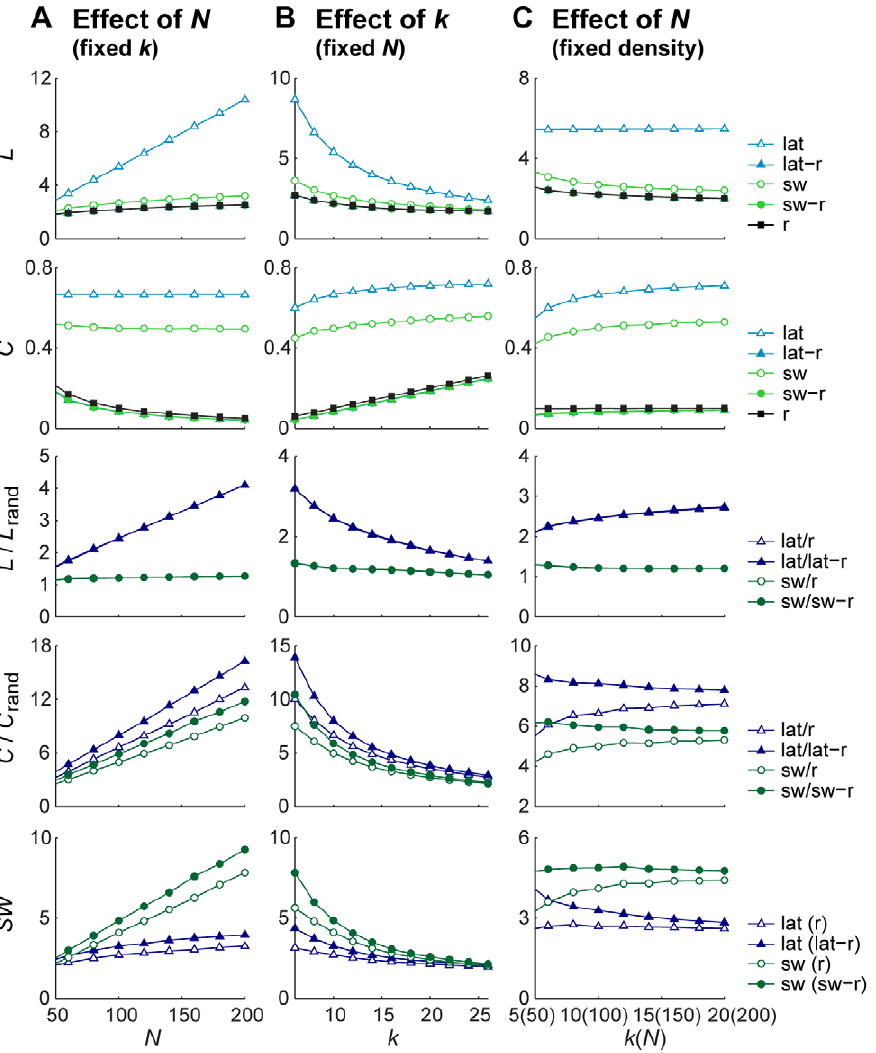
Figure 3. Normalized graph measures using random surrogates remain sensitive to network size and average degree. Path length ( L ) and clustering coefficient ( C ) normalized by dividing values from a lattice and small-world network (rewiring probability=0.1) by those of random networks still depend on the network’s number of nodes ( N ) and average degree ( k ) because their curves as function of N and k are specific for each type of network. Small-world networks (sw) fall in between lattices (lat) and random networks (r) and so the influence of normalization on the N,k - dependence is smaller compared to lattices. Since L for small-world networks is close to that of random networks, normalization improves the independence of N and k (more horizontal curves). By contrast, C is close to that of lattices and normalization introduces a bias that is larger compared to the non-normalized measure. Because of this, the small-world index ( SW ) is also greatly affected by N and k . There is little to no difference for Erdo¨s-Re´nyi networks and random networks with the same degree distribution as the original network (lat-r, sw-r) and even coincide for L . The legend for SW indicates between brackets the type of random surrogates used in the calculation. A : Effects of changes in the number of nodes ( N ) while keeping the average degree constant ( k =10). B : Effects of changes in the average degree ( k ) while keeping the number of nodes constant ( N =100). C : Effects of changes in the number of nodes while keeping the edge density constant (0.1). Note that k now increases with network size. In this case, the sensitivity to network size is greatly